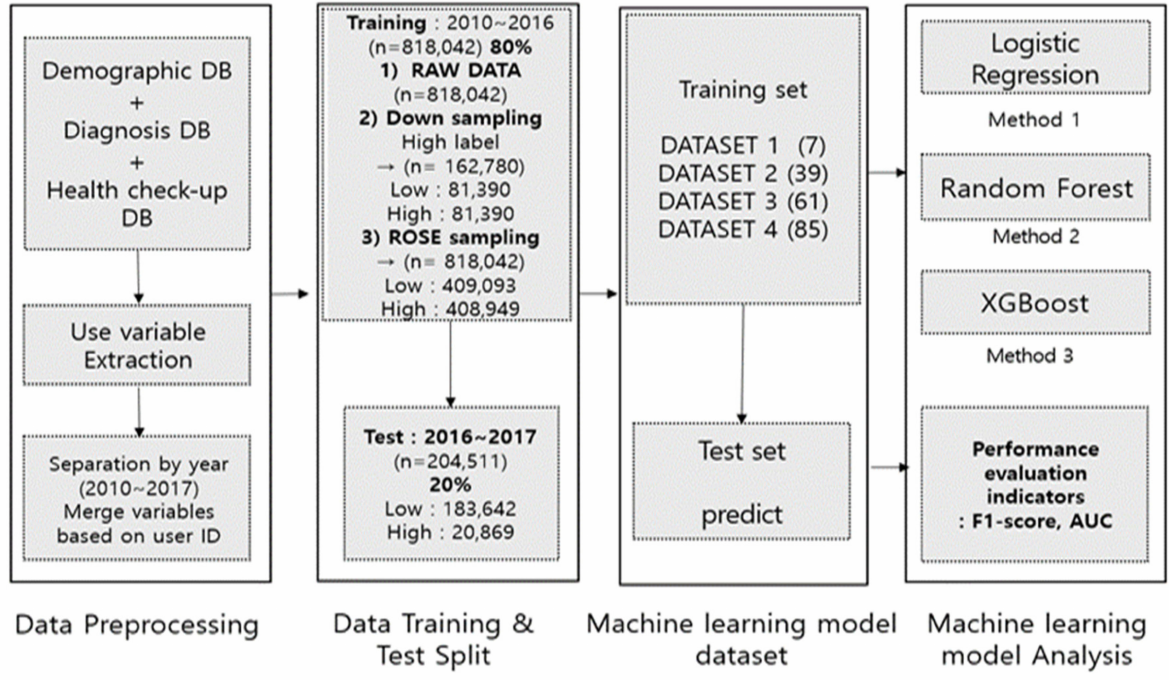
Figure 2. Experiment